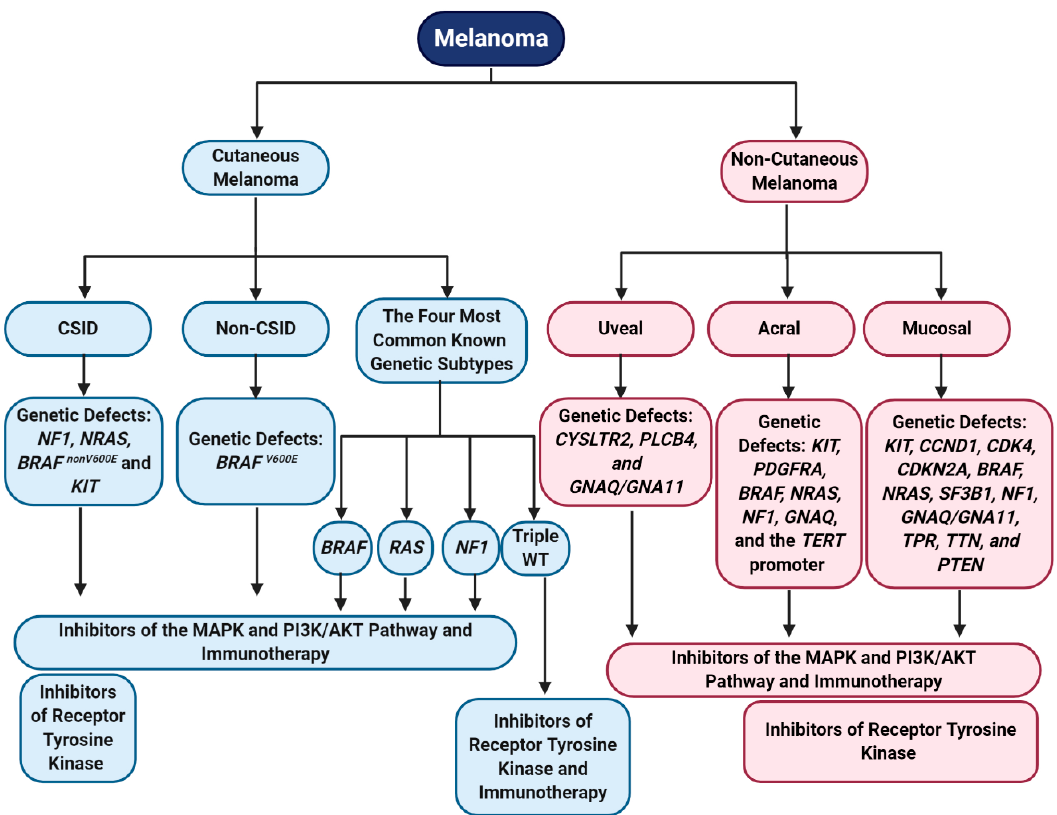
Figure 1. Melanoma can be segregated into distinct subtypes, based on anatomical location, sun exposure, and genetic profiles, which affect treatment responses to MAPK, PI3K/AKT, receptor tyrosine kinase inhibitors, and immunotherapies. CSID—Chronically Sun Induced melanoma; non-CSID—Non-Chronically Sun Induced melanoma; and triple WT—Triple Wild-Type. Created with BioRender.com